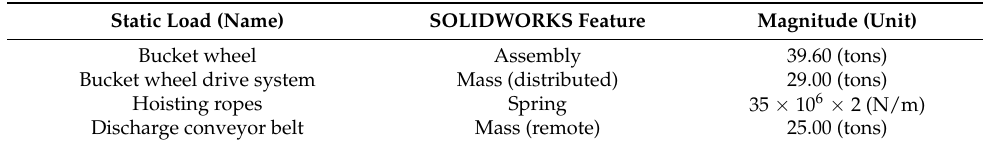
Table 1. Summary of the loads (static) exerted on the BWE boom, their magnitude and the SOLID- WORKS feature used to model